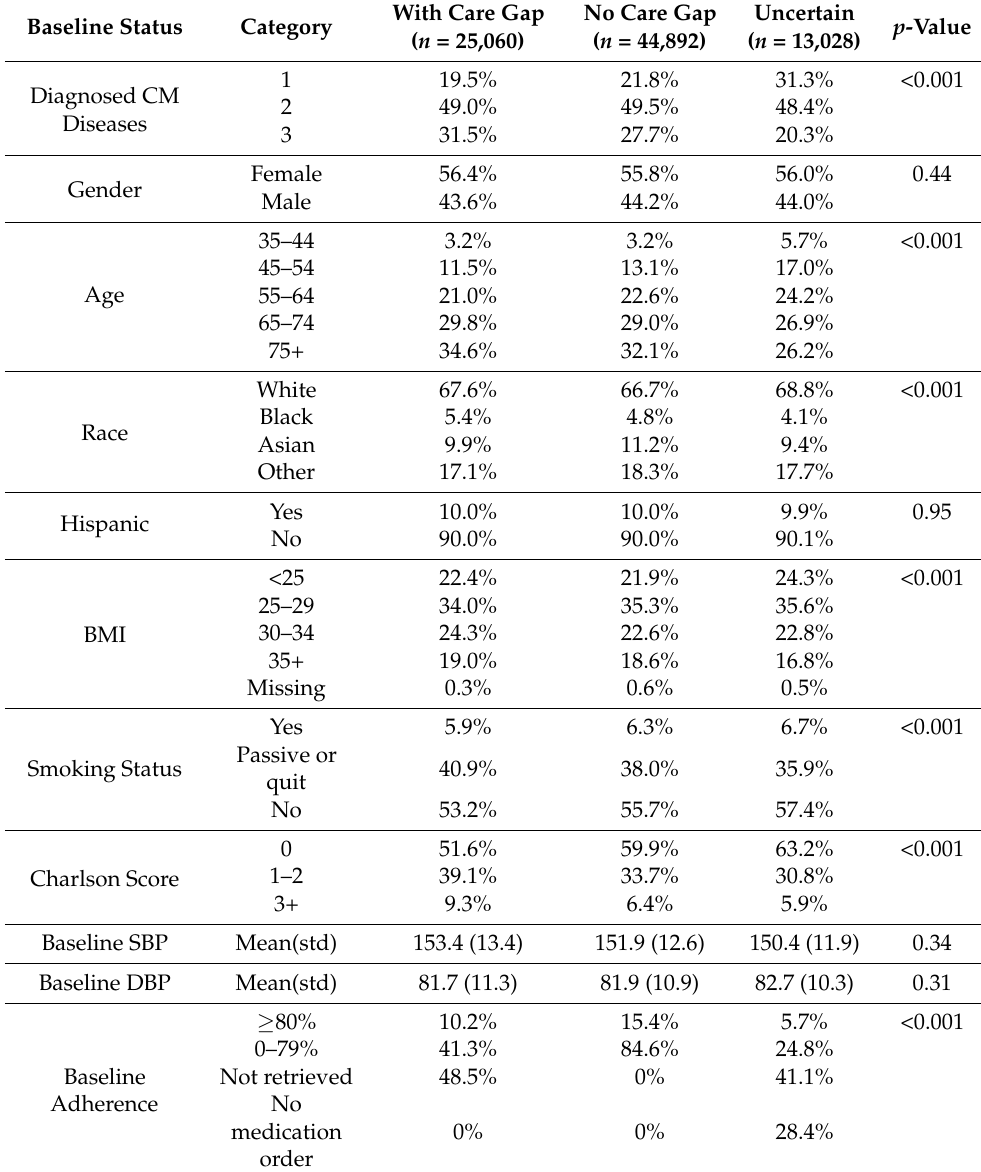
Table A2. Demographic and clinical characteristics of primary care patients 35+ years old who are included in care gap analysis for hypertension in Table 4.